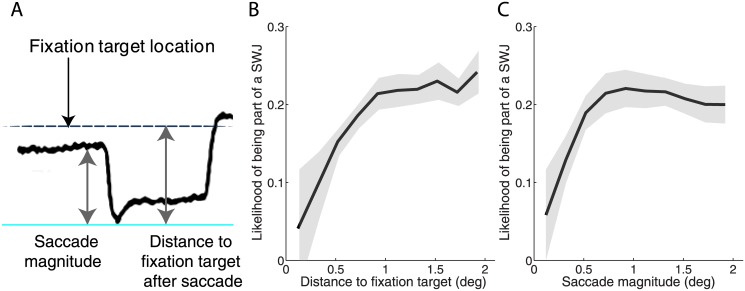
Relationship between fixation error and subsequent SWJ generation.
A) Schematic illustration of a fixation error. The fixation target location, the magnitude of the first saccade in the SWJ, and the distance to the fixation target after the first SWJ saccade are indicated. Relationship between a saccade’s likelihood of being part of a SWJ and B) the post-saccadic distance to the fixation target and C) the saccade’s magnitude. Both relationships follow a logistic regression (p-values < 0.05), where a saccade’s likelihood of being part of a SWJ increases with both the distance to the fixation target after the saccade [Friedman's test (5, 4) = 12.32; p = 0.015] and the saccadic magnitude [Friedman's test (5, 4) = 16.64; p = 0.002)] up to 1 deg, and then plateaus for values > 1 deg [p-values >0.9]. Grey shadows indicate the s.e.m. across monkeys (n = 5).